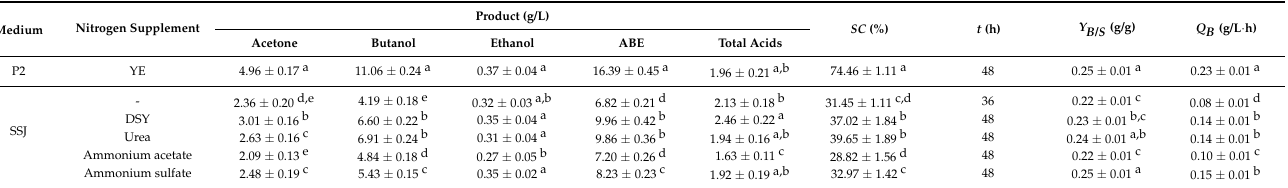
ABE: acetone, butanol, and ethanol concentrations. Total acids consisted of acetic and butyric acids. The experiments were performed in triplicate and the results are shown as means ± SD. a,b,c,d,e Mean values followed by the same letter within the same column were not significantly different as assessed by Duncan’s multiple range test with a critical value of 0.05. SC = sugar consumption; t = fermentation time; Y B/S = butanol yield; Q B = butanol